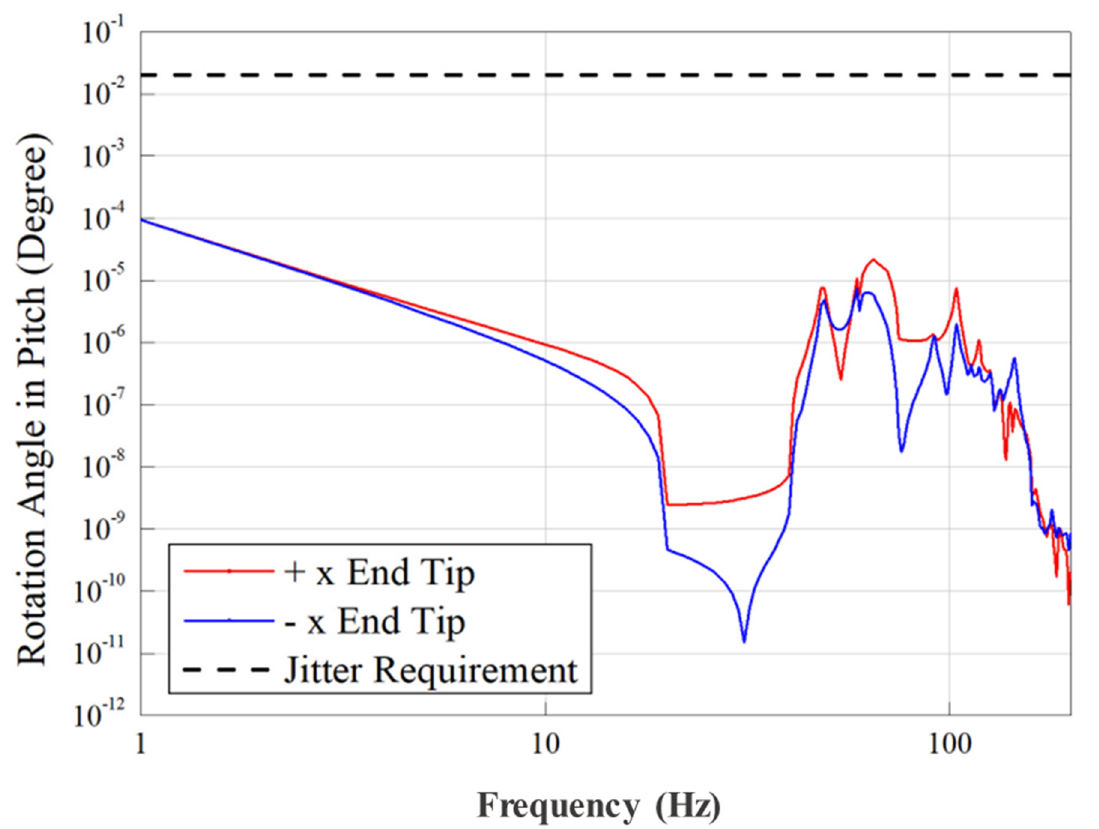
± end tips with regard to the reaction wheel